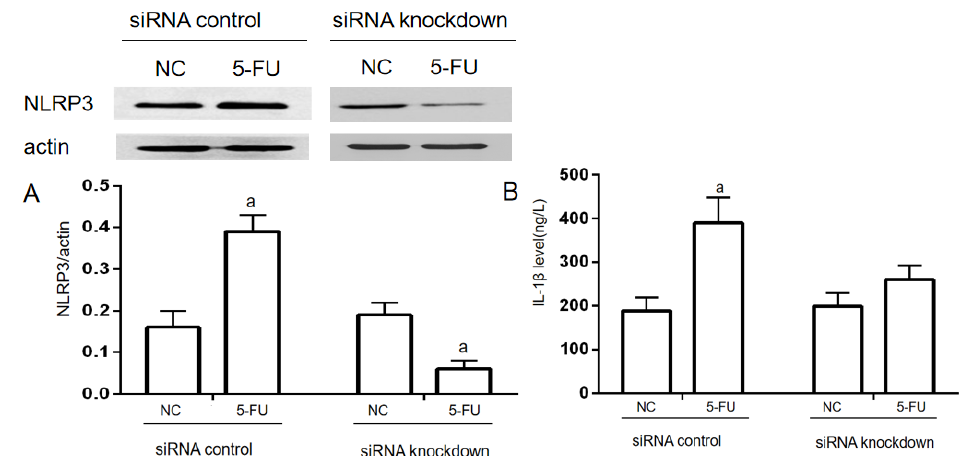
Figure 4. NLRP3 knockdown on 5 − FU-induced IL − 1 β expression in THP − 1 cells ( n = 3/group). NLRP3-siRNA was used for NLRP3 knockdown in THP − 1 cells. The siRNA-NLRP3 and ExFect 2000 Transfection Reagent mixture was added into the culture medium for 24 h. Then, the final concentration of 2.5 mmol/L 5-FU was added into the medium to induce the inflammatory response. ( A ) The expression of NLRP3 was determined by Western blotting assay. ( B ) The level of IL − 1 β in the culture medium was determined by ELISA assay. Each experiment was repeated at least three times. Data are expressed as the mean ± SEM. a— p < 0.05, vs. the NC